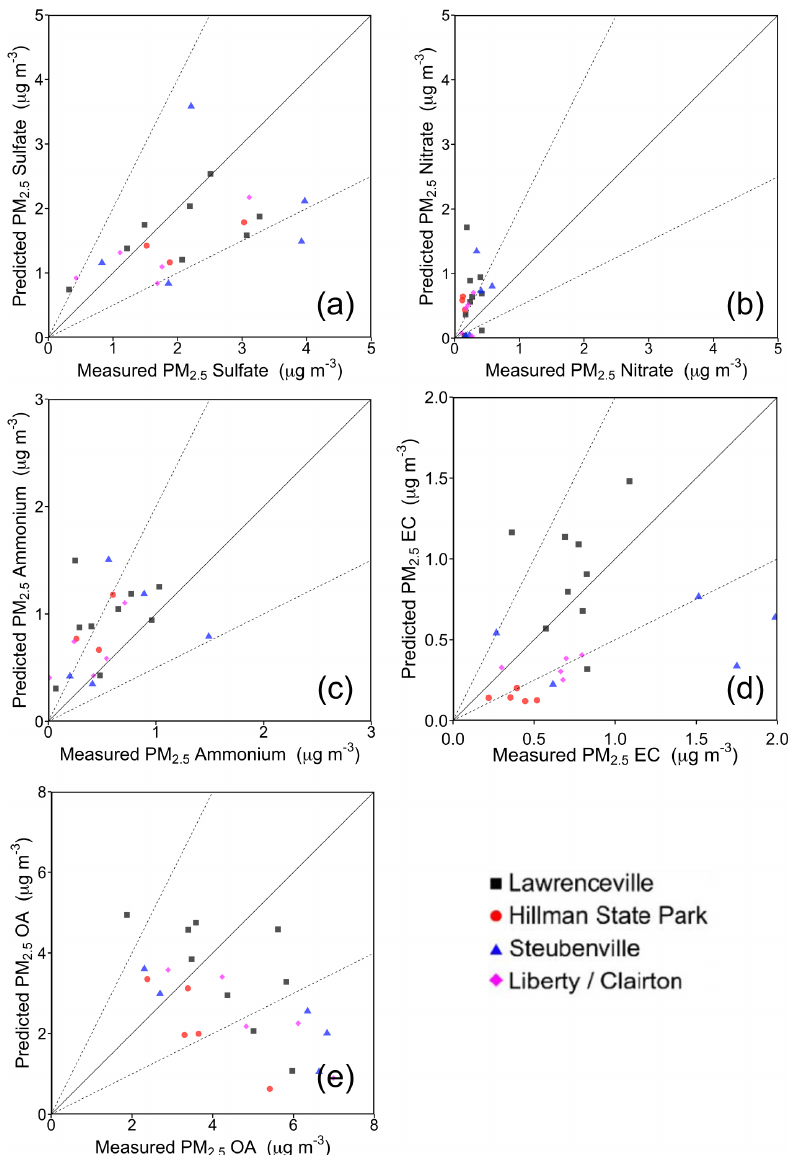
Figure 4. Comparison of PMCAMx-v2.0-predicted concentrations of PM 2 . 5 (a) sulfate, (b) nitrate, (c) ammonium, (d) elemental carbon, and (e) organic aerosol with measurements from EPA-CSN sites during July